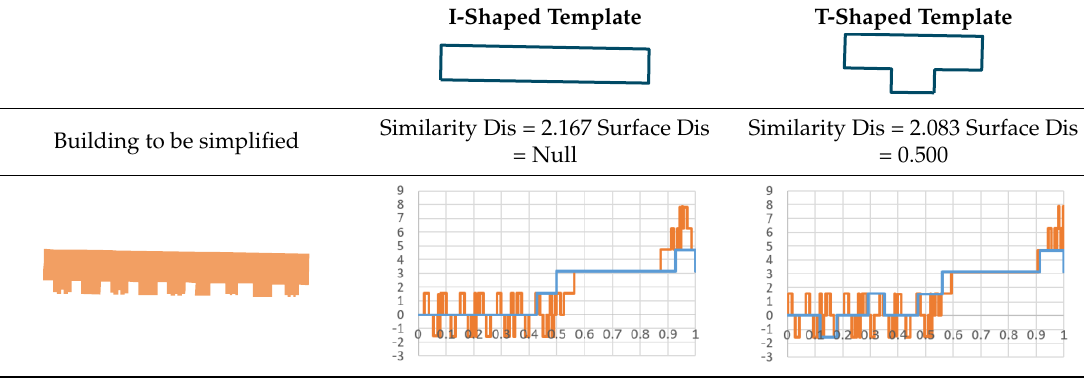
Table 2. Comparative analysis of a building matched by I-shaped and T-shaped templates.